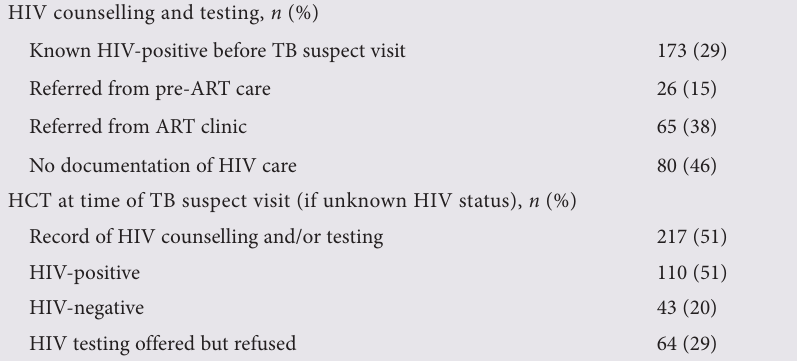
Table 3. HIV activities recorded among 602 TB suspects at 3 primary care clinics in Johannesburg, South Africa HIV counselling and testing, n